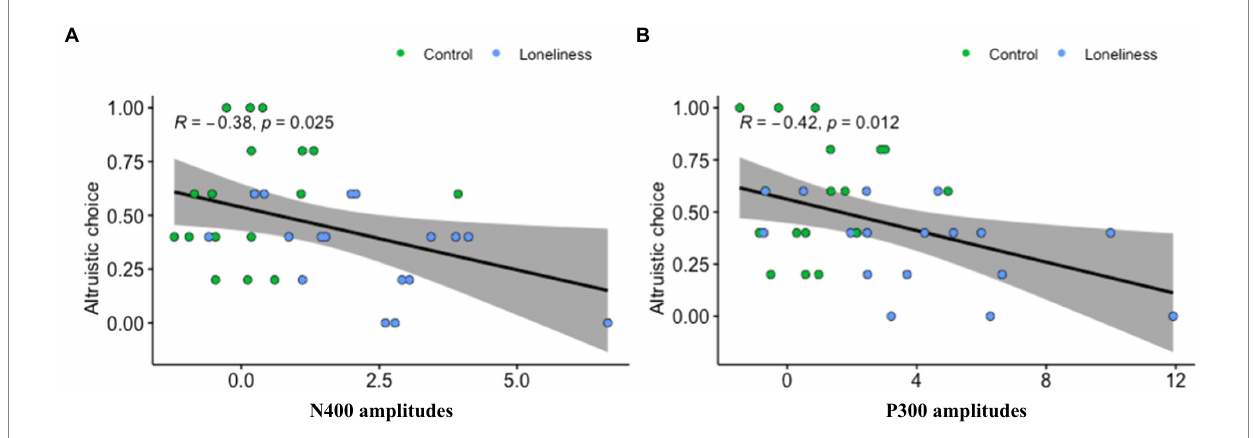
FIGURE 2 Correlation between N400/P300 and prosocial behavior. (A) The relationship between prosocial behavior and the ERP data using two channels from the frontal brain (F1, F2) was highly correlated with prosocial behavior. (B) The relationship between prosocial behavior and the ERP data using two channels from the posterior brain (PO3, PO4) was highly correlated with prosocial